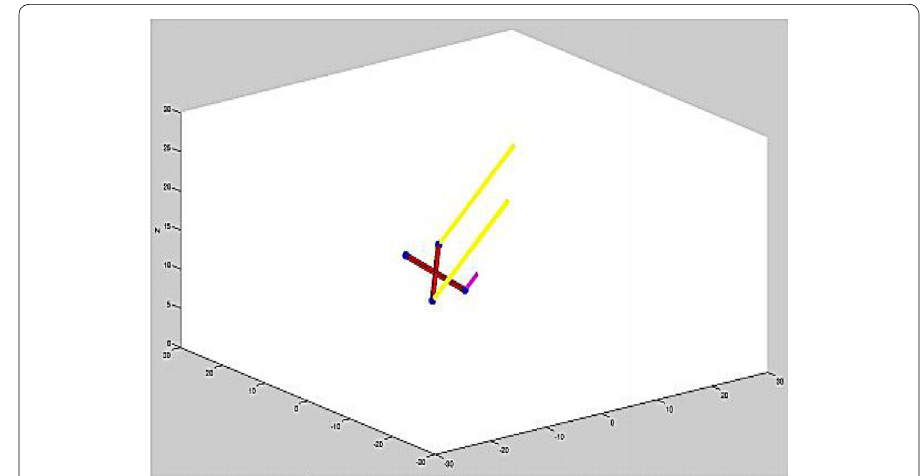
Fig. 7 Visualization of the quadcopter in three dimensions